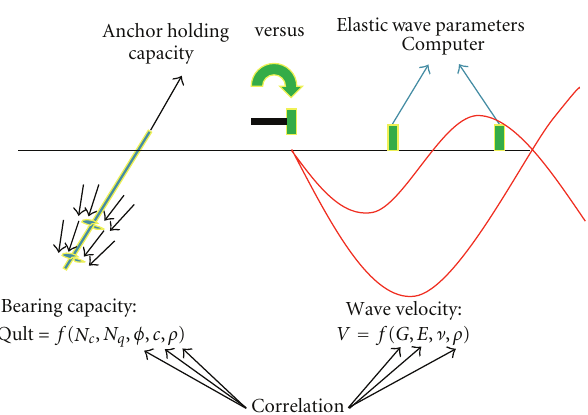
Figure 2: Correlation between anchor holding capacity and elastic wave